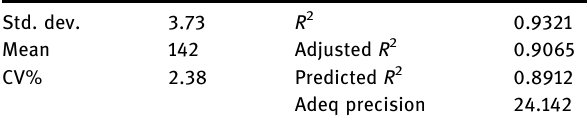
Table 12: Fit statistics for tear